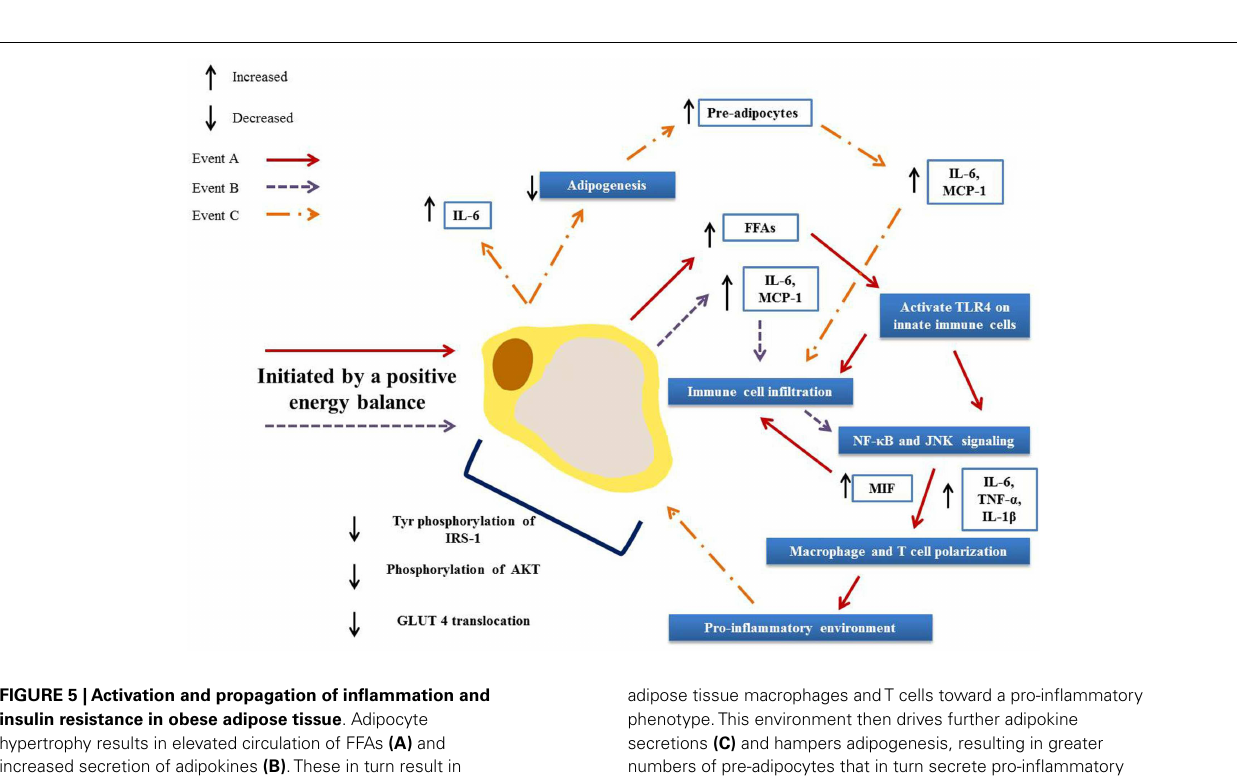
FIGURE 5 |Activation and propagation of inflammation and insulin resistance in obese adipose tissue . Adipocyte hypertrophy results in elevated circulation of FFAs (A) and increased secretion of adipokines (B) .These in turn result in immune cell infiltration and the activation of pro-inflammatory signaling pathways, driving further infiltration and the polarization of